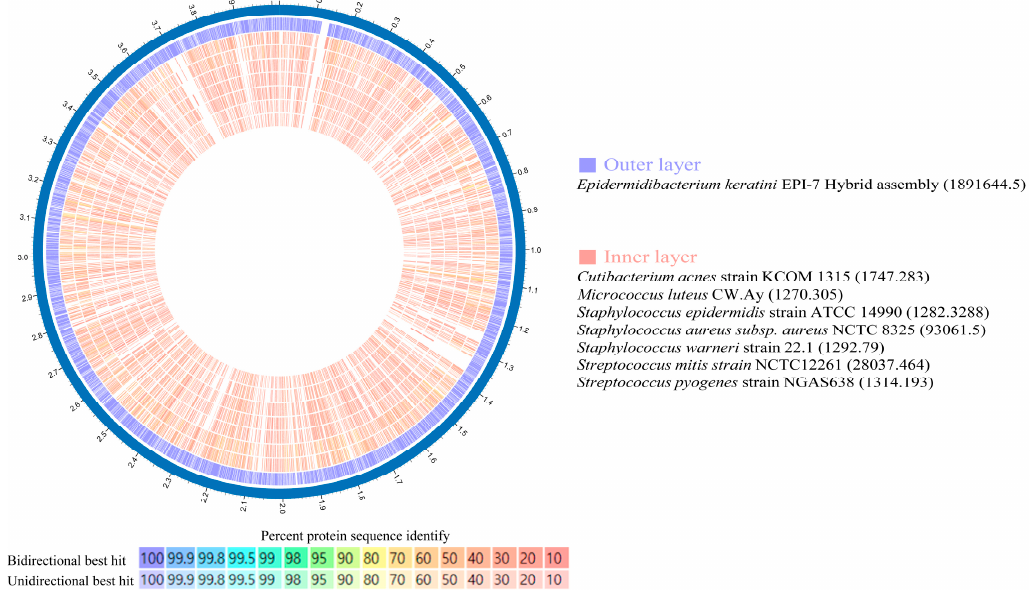
Figure 5. Amino acid identity (AAI) using Proteome comparison (PATRIC). Proteome comparison analysis based on amino acid sequence using PATRIC showed that E. keratini EPI-7 T had a low AAI with those of skin flora. However, Cutibacterium acnes (244) and Micrococcus luteus (298) had a relatively high AAI ratio of more than 90%, less than 50%, with E. keratini EPI-7 T .